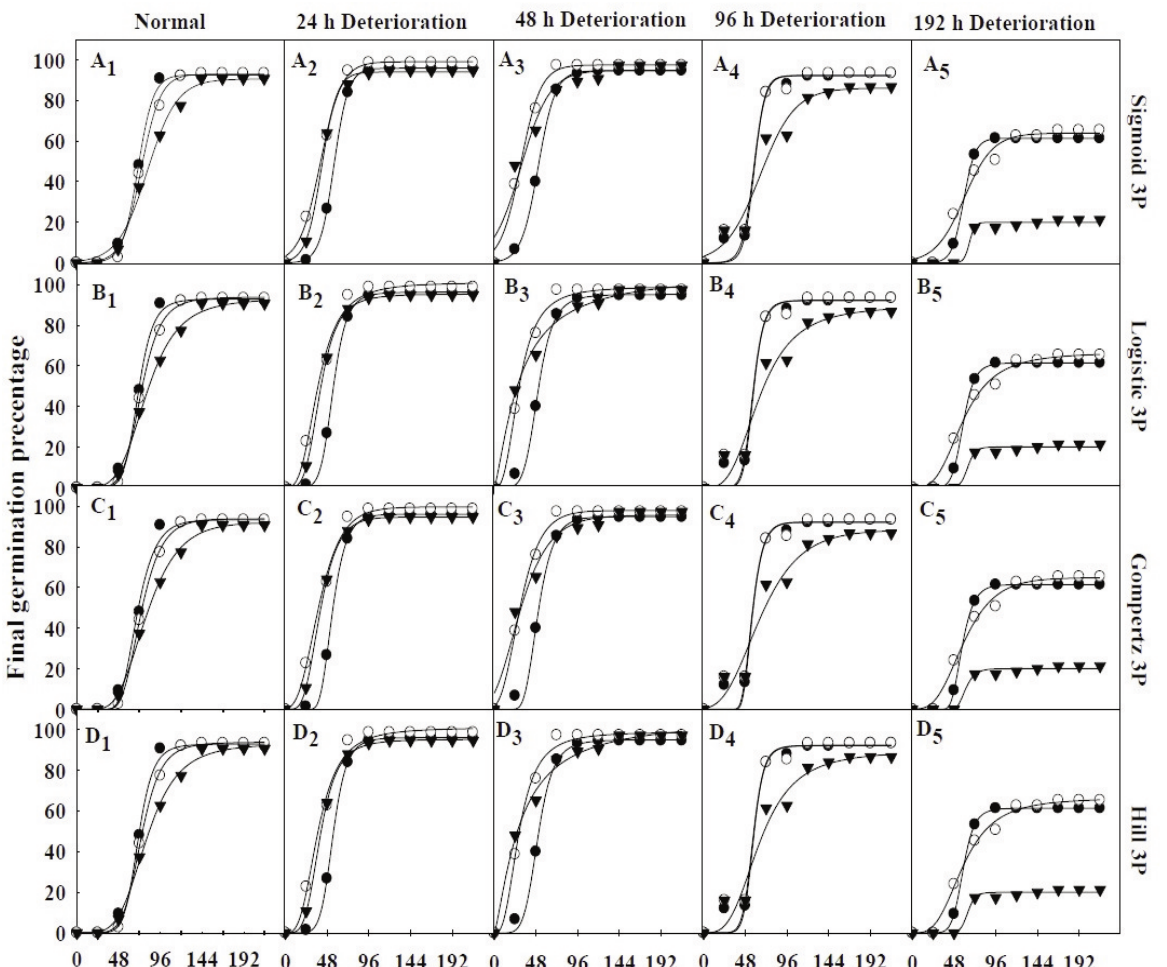
Fig. 1 - Model fit function 3 parameter of germination ecotypes okra ( Abelmoschus esculentus L.) under deterioration condi- tion. ● Ahwaz, ○ Isfahan and ▲ Mashhad